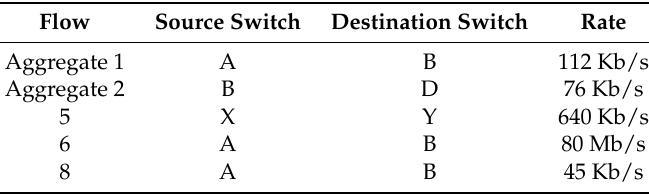
Table 3. Sample flow